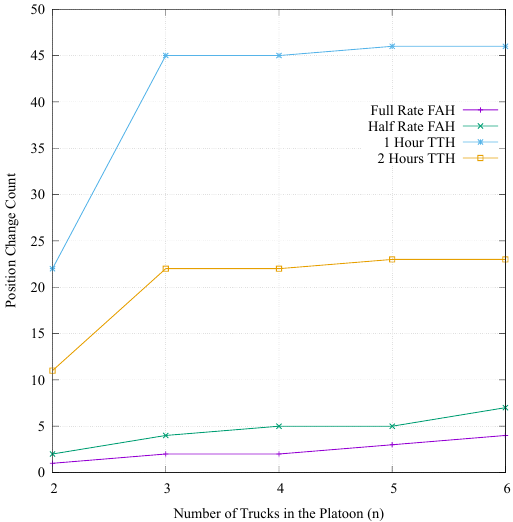
Figure 2. Comparison of Switching Count.